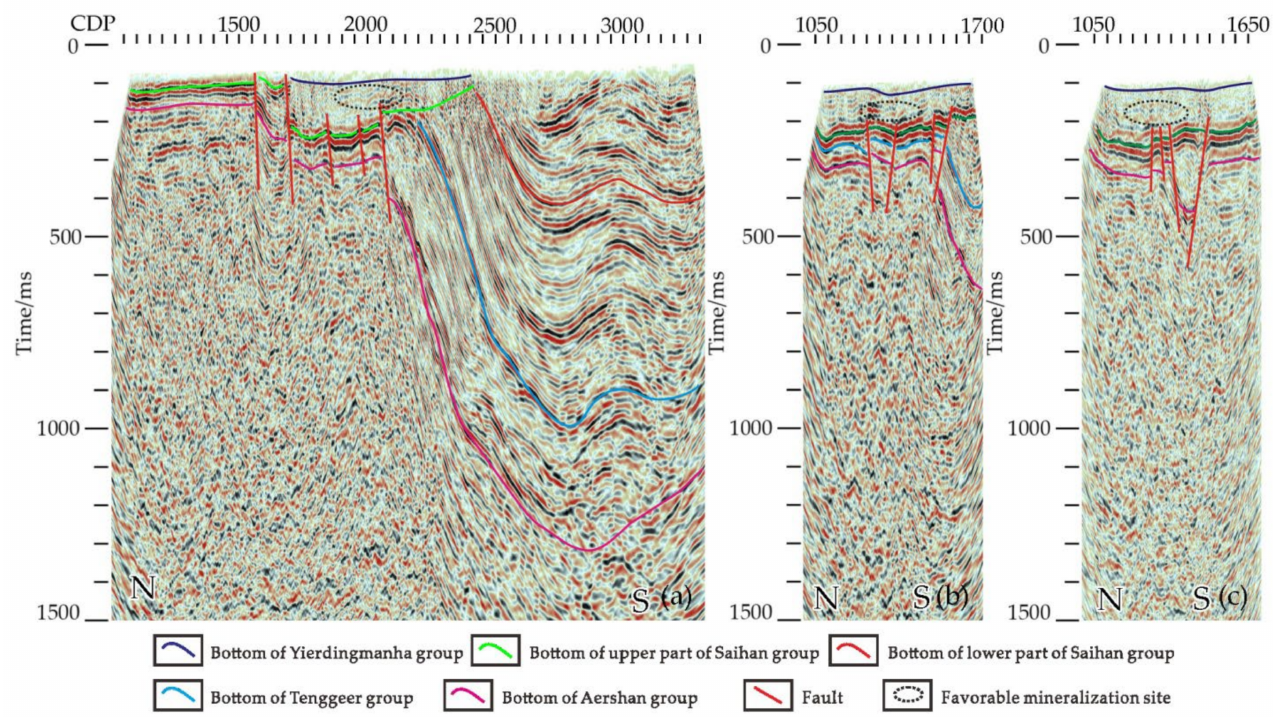
Figure 9. The seismic survey results on Saihangaobi uranium deposits; Q1 ( a ), Q2 ( b ), Q3 ( c ). The target formation (above the green line) resembles a “U” shape filled with fluviatile deposits. The U mineralization is located on the bottom and the slopes of the “U”; under the target layer, very thick reducing formations have developed that form a “big depression”, generally exceeding 1000 m at the deepest point. In the southern section, the reducing formation contacts the overturned “U” formation at a large angle (about 25 ◦ ). The seismic phase of the mineralization-favoring site shows weak–medium amplitudes, low–medium frequency, low continuity, and a wavelike reflection